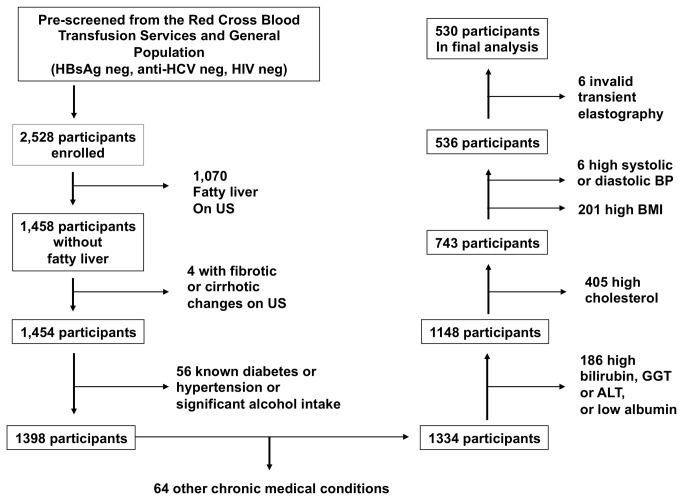
Flow diagram of health participants from the Hong Kong Liver Health Census.